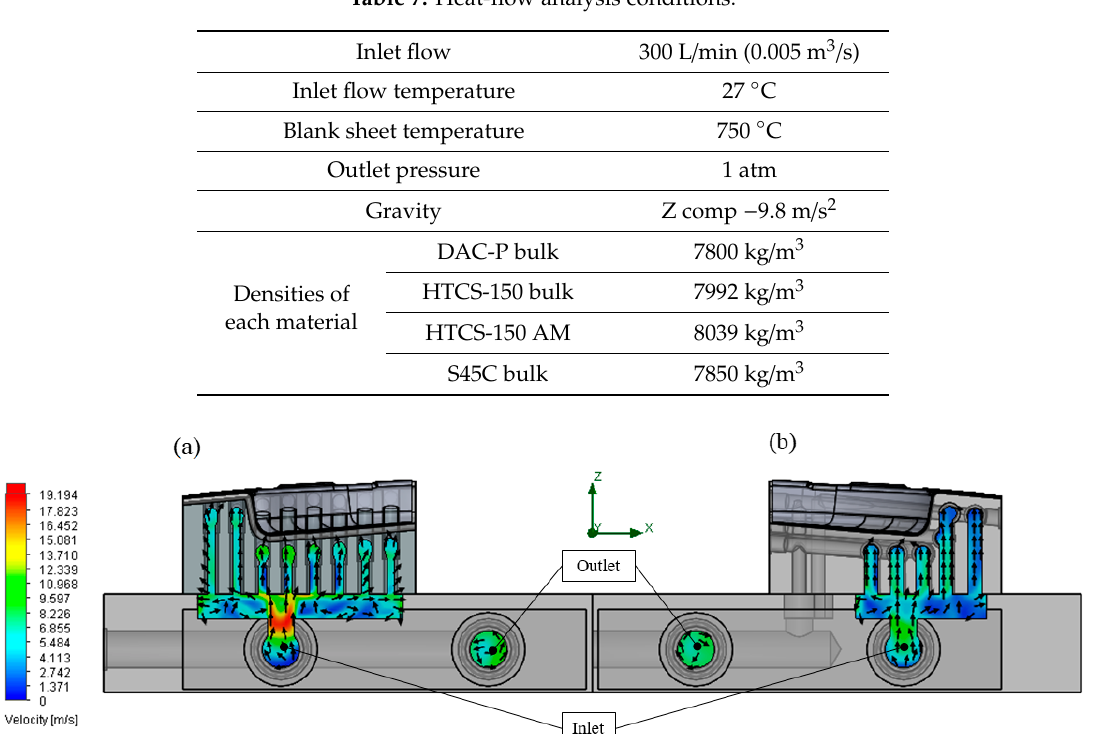
Table 7. Heat-flow analysis conditions.